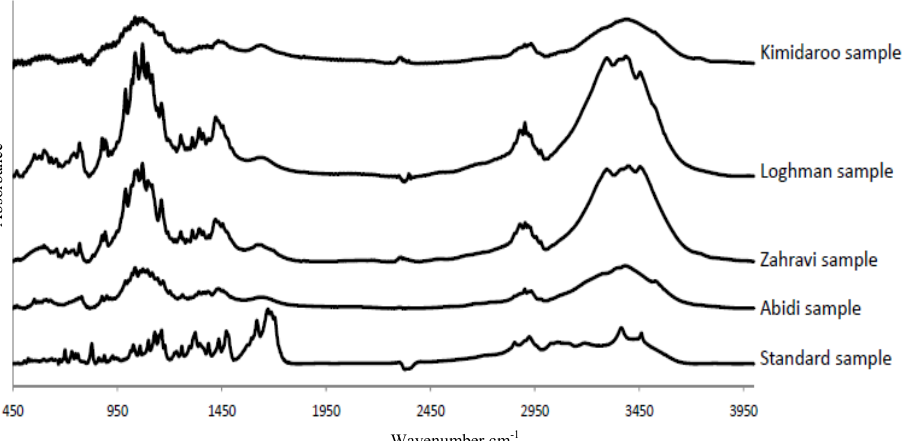
Figure 1. FTIR spectra, in KBr disks of lorazepam standard and four pharmaceuticals used in this study. Note: spectra were shift on the absorbance axis to clearly show their bands. Instrumental conditions: 25 scans, 4 cm -1 nominal